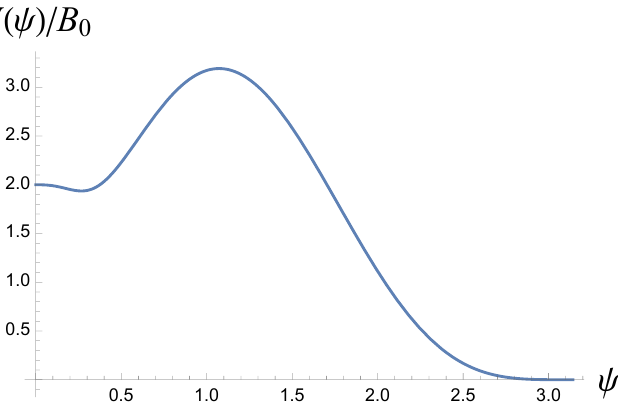
Figure 1 . The NS5-brane polarization potential for p=M = 0 : 03 and B 0 (cid:17) e 4 A 0 p (cid:22) 3 =g s . At the north pole ( = 0) there are p anti-D3-branes that polarize into an NS5-brane carrying charge Q ( ) at the metastable minimum ( min ). This con(cid:12)guration can decay non-perturbatively to the supersymmetric minimum at the south pole ( = (cid:25) ), where the p anti-D3-branes annihilated and the (cid:12)nal con(cid:12)guration contains ( M (cid:0) p )